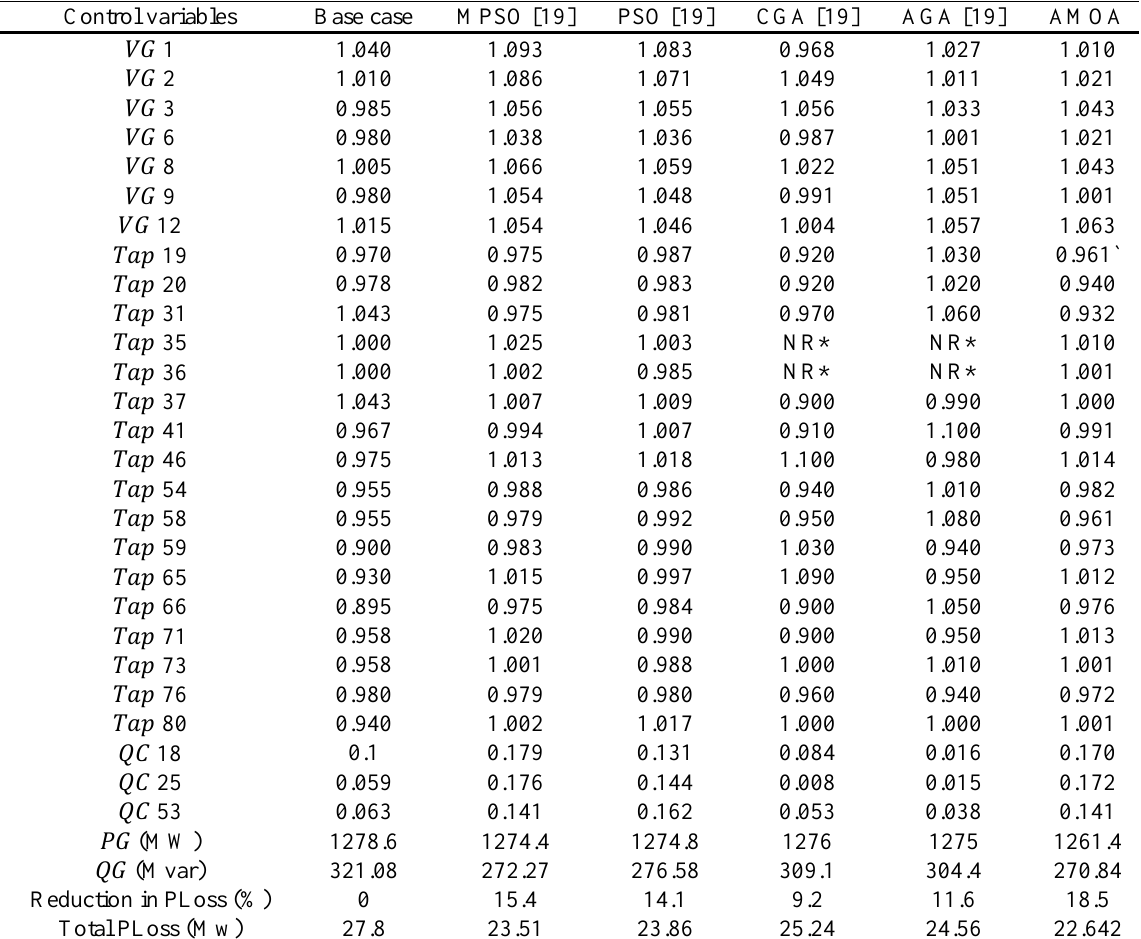
Table 9. Simulation results of IEEE −57